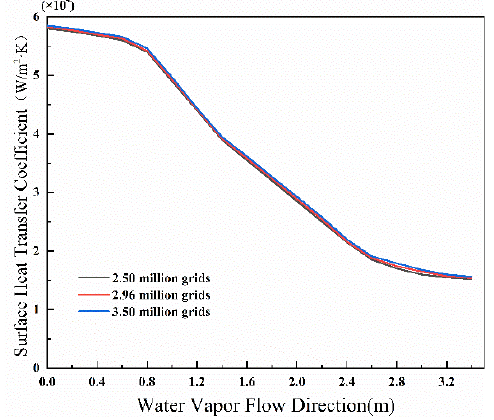
Figure 3. Grid independence verification diagram.